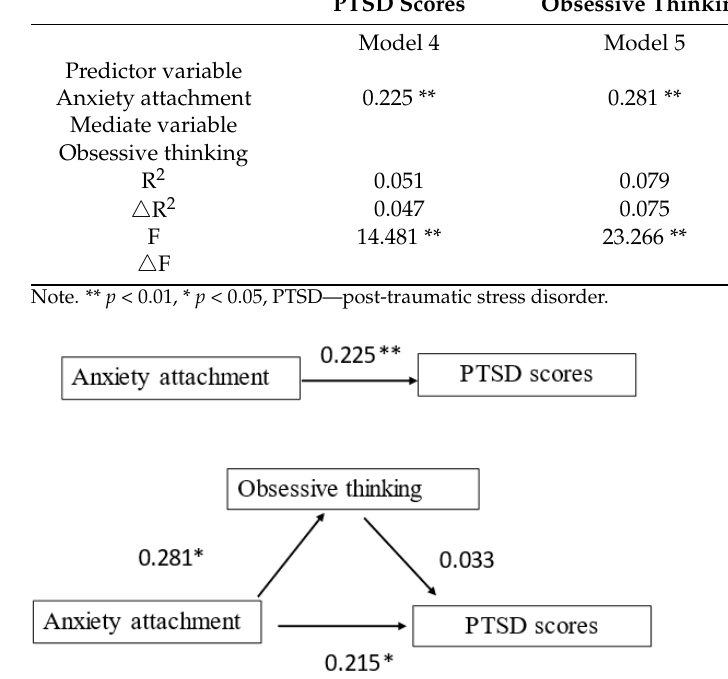
Table 3. The effect of attachment anxiety on the PTSD scores: the mediating role of obsessive thinking. PTSD Scores